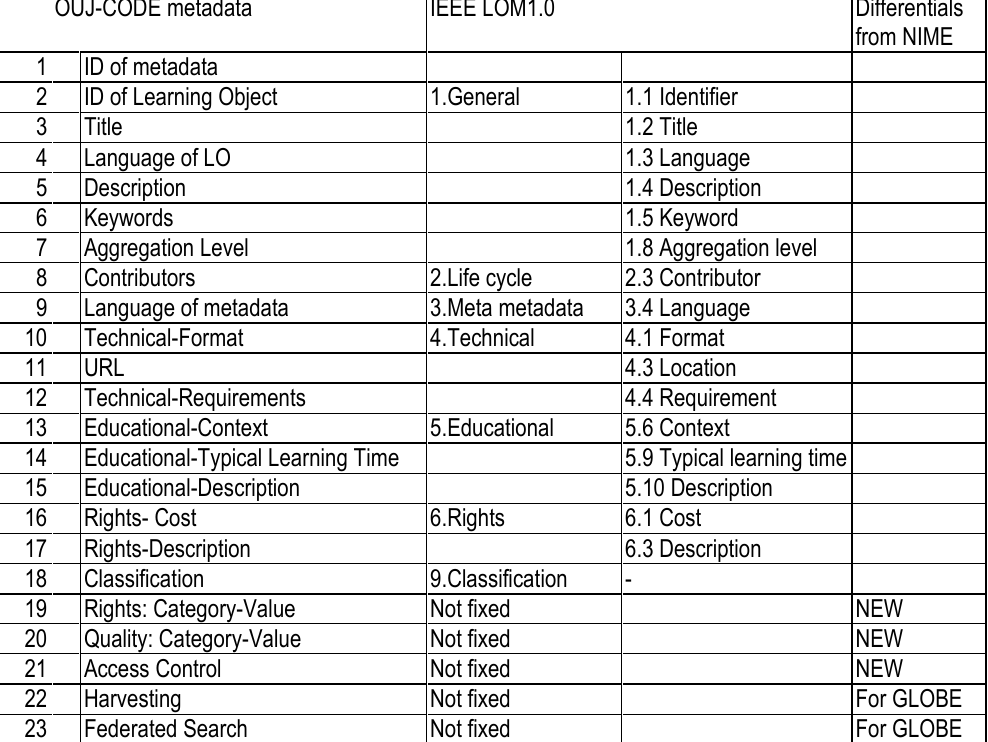
Table 1. LOM items in the new OUJ-CODE search system (partially under